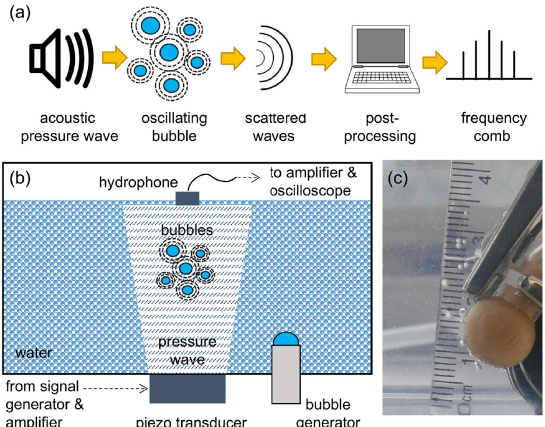
Figure 13. ( a ) Schematic diagram of the AFC generation using oscillations of gas bubbles in water. The oscillations are driven by a single-frequency ultrasound pressure wave. Acoustic waves scattered by the bubbles are recorded and post-processed to obtain a spectrum consisting of equidistant peaks. ( b ) Schematic of an experimental setup, where bubbles are created in a stainless steel tank using a bubble generator, the driving pressure wave is emitted by an ultrasonic transducer, and waves scattered by the bubbles are detected by a hydrophone. ( c ) Photograph of typical gas bubbles emitted by a bubble generator. Reproduced from [21] published by Springer Nature under the terms of the Creative Commons CC BY license.